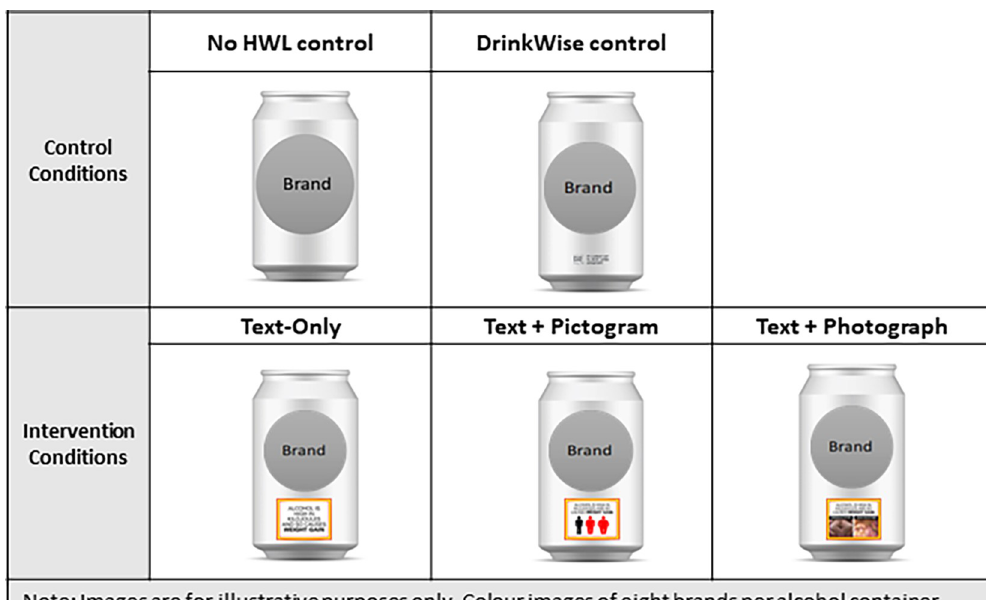
Fig 2. Appearance of warning labels on one example of an alcohol container